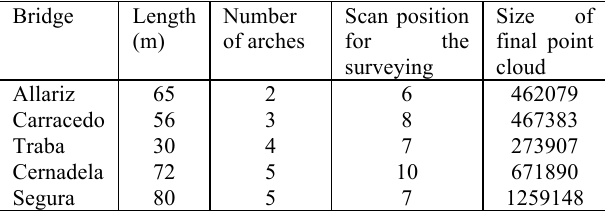
Table 1. Summary of the laser scanning survey of the bridges used to validate the